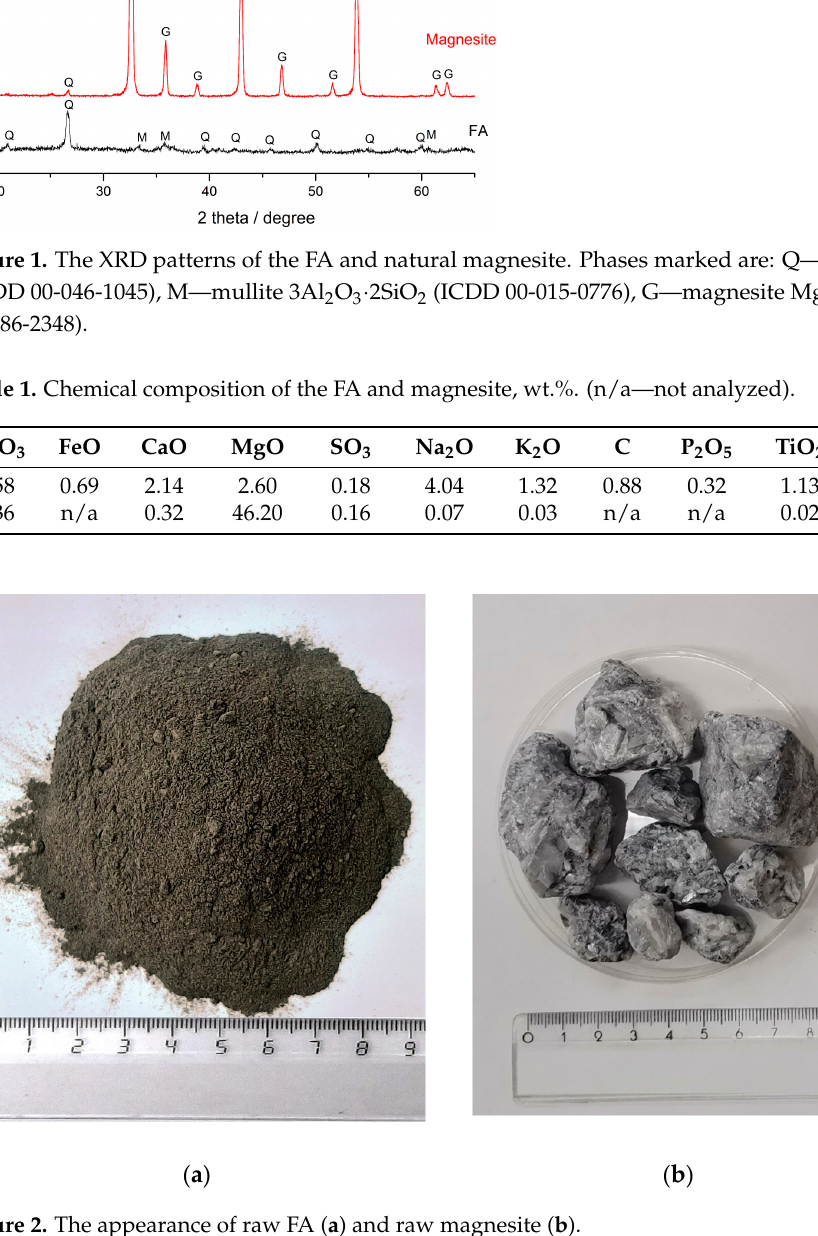
Figure 2. The appearance of raw FA ( a ) and raw magnesite ( b